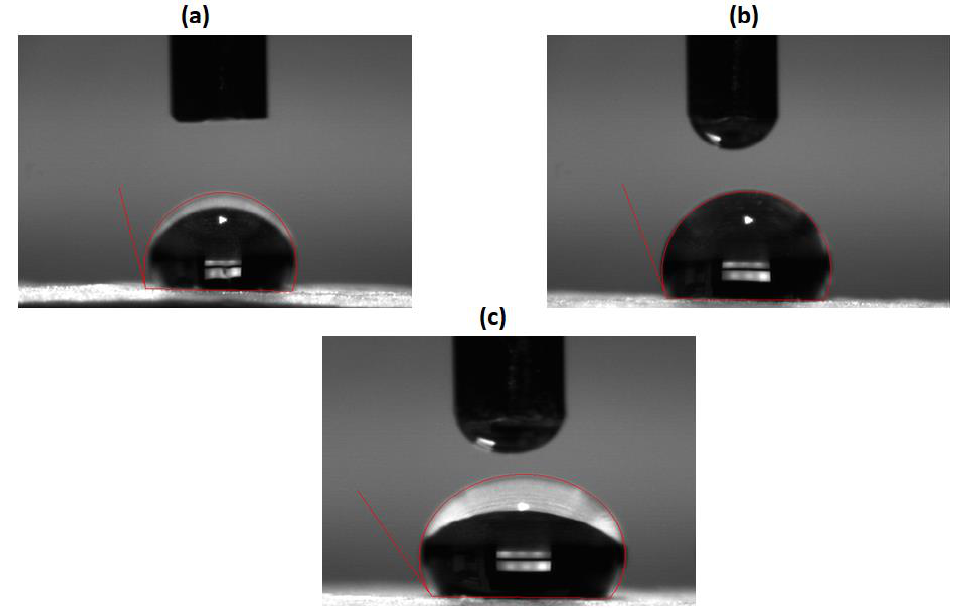
Figure 4. Contact angle images of ( a ) PU, ( b ) PU / BASIL and ( c ) PU / BASIL / TiO 2